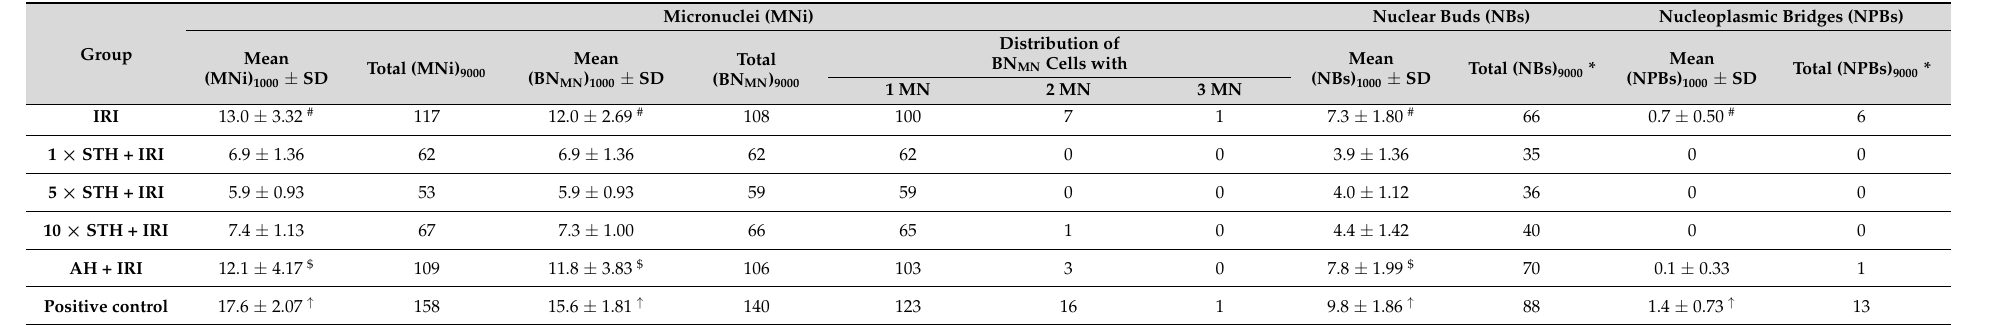
Table 6. Micronuclei (MNi), nuclear bud (NB), and nucleoplasmic bridge (NPB) formation after treatment with different combinations of cytotoxic drug irinotecan (IRI) with strawberry tree honey (STH) and artificial honey (AH). Single-IRI-treated cells and positive control (bleomycin—15 mg/L) cells were studied in parallel. Micronuclei (MNi) Nuclear Buds (NBs) Nucleoplasmic Bridges